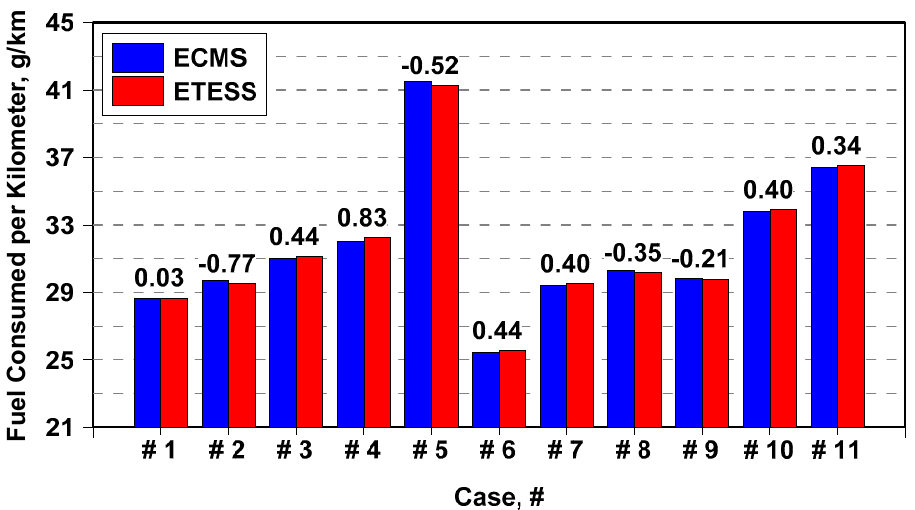
Figure 17. Assessment between online ETESS and ECMS of kilometric consumed fuel and percent difference in the cases of Table 3.